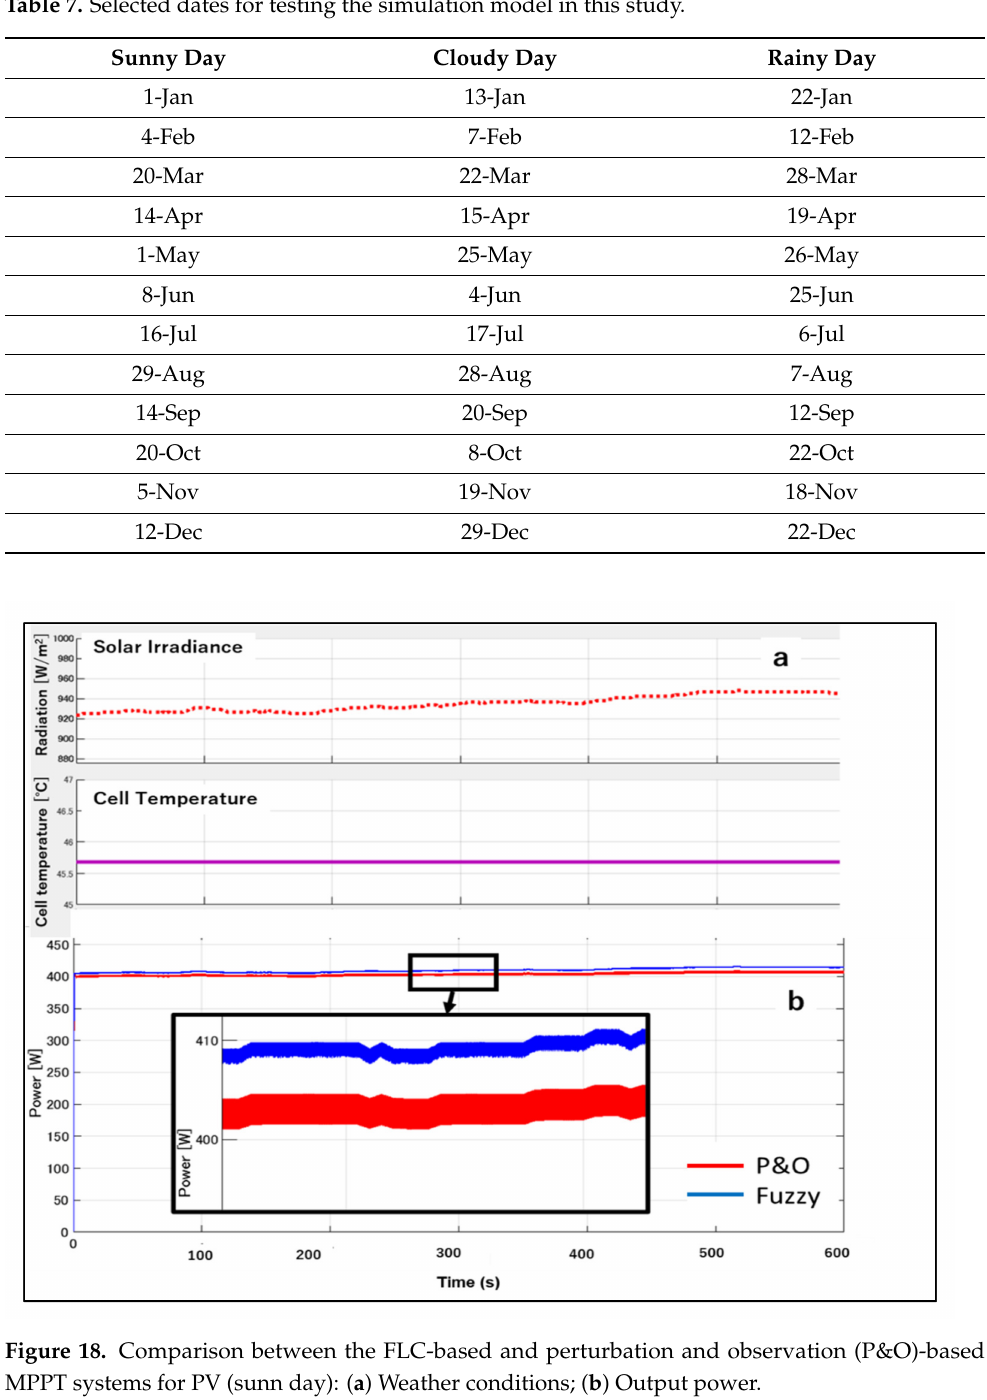
Table 7. Selected dates for testing the simulation model in this study.